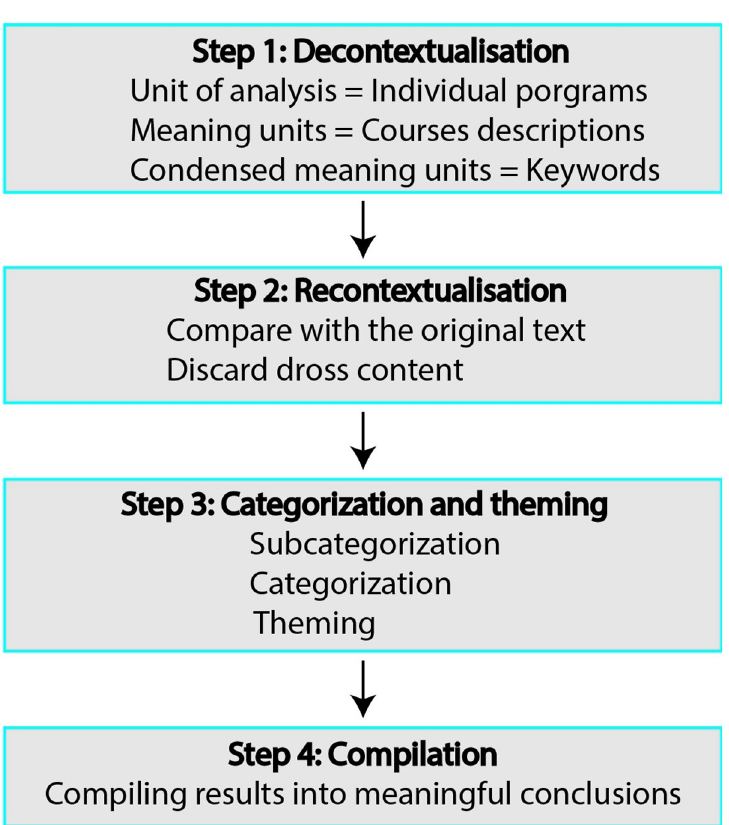
Fig 3. Overview of the data analysis